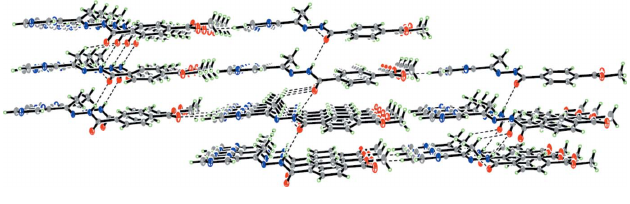
Figure 2 Molecular packing for the title compound viewed along the b -axis direction. Dashed lines indicate hydrogen bonding.